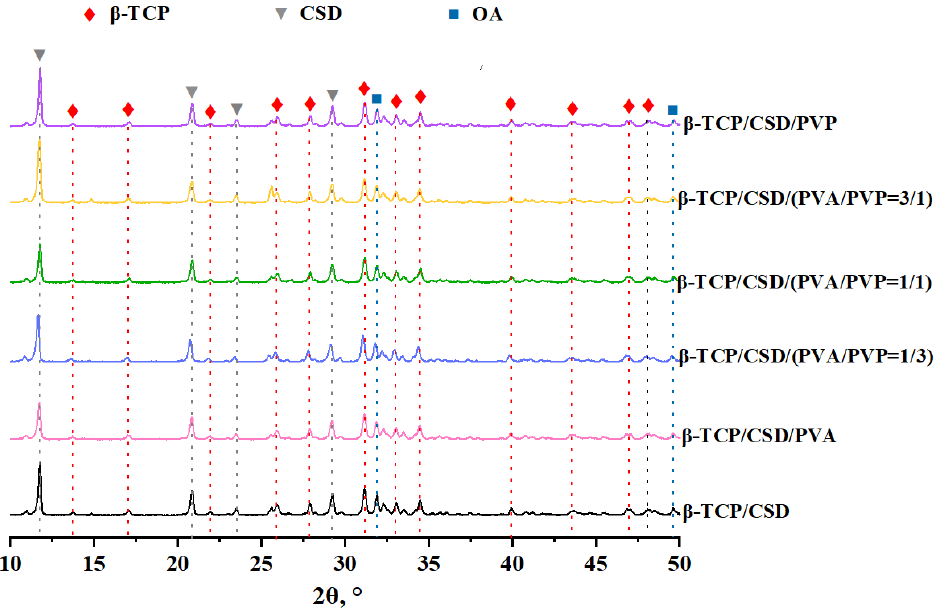
3 (PO 4 ) 2 , ( b ) Ca 10 (PO 4 ) 6 O.